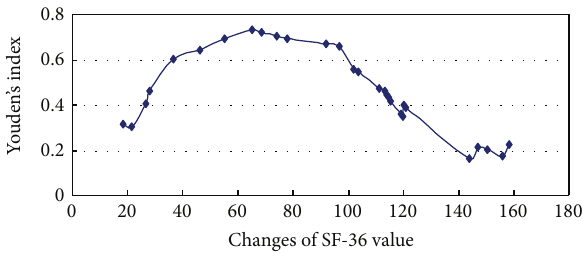
Figure 3: Changes of Youden’s index in GERD